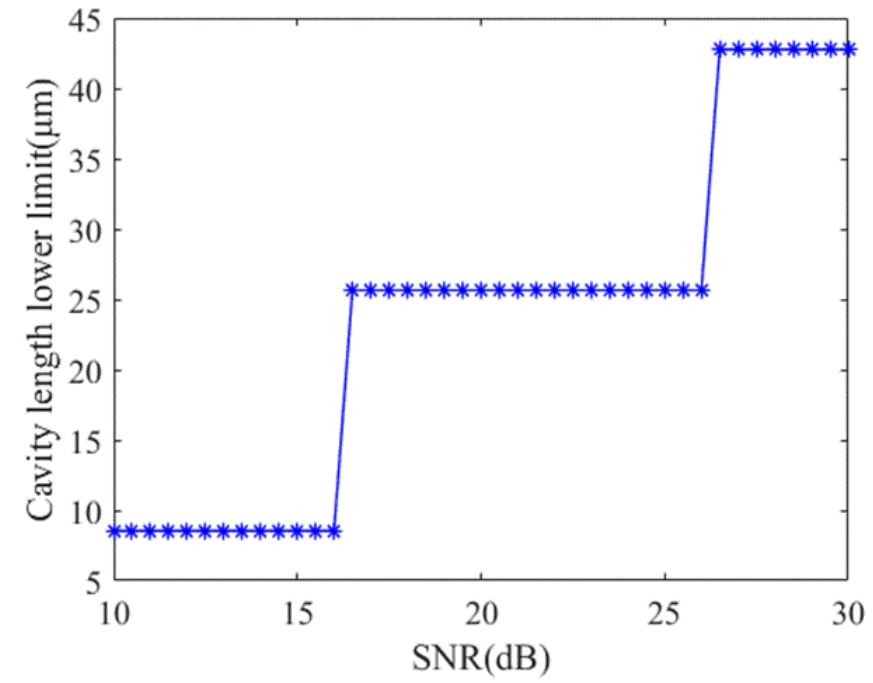
Figure 7. The relationship between minimum EFPI cavity length and SNR.